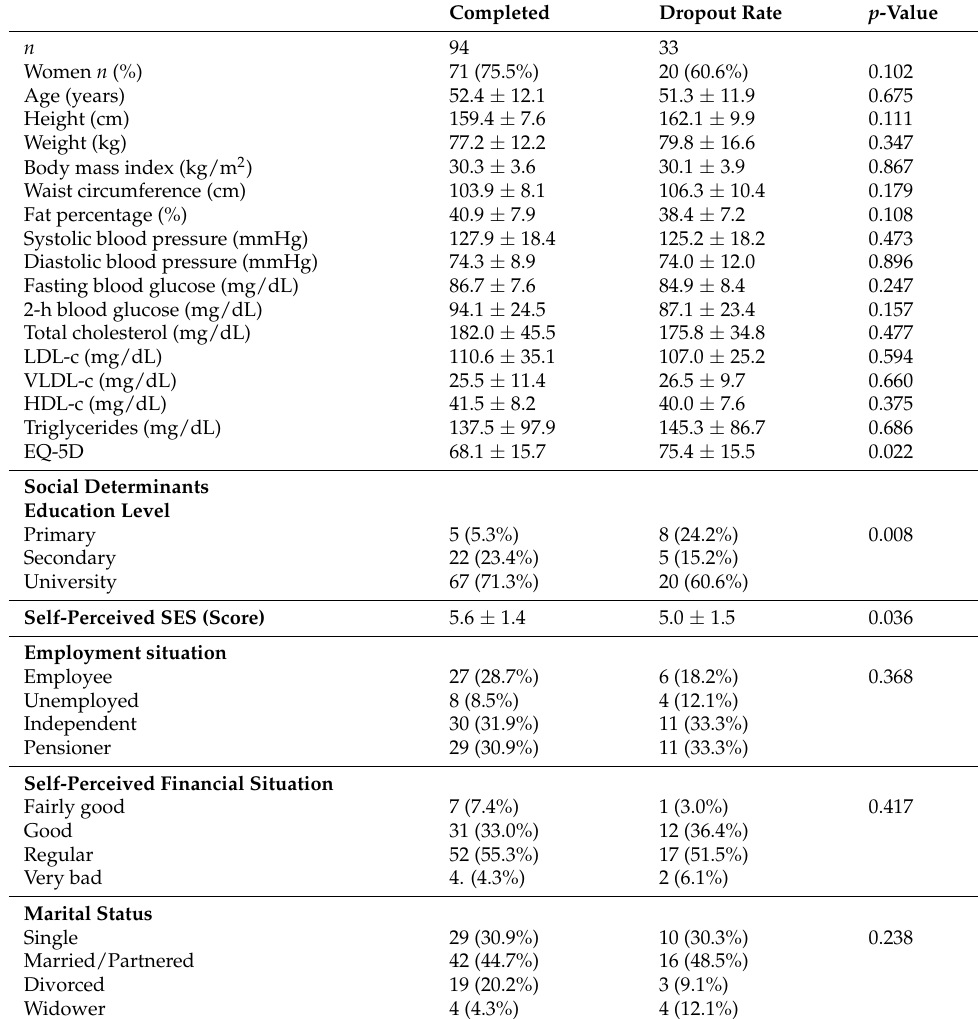
Table 2. Characteristics of the participants who completed or dropped out of the first phase.